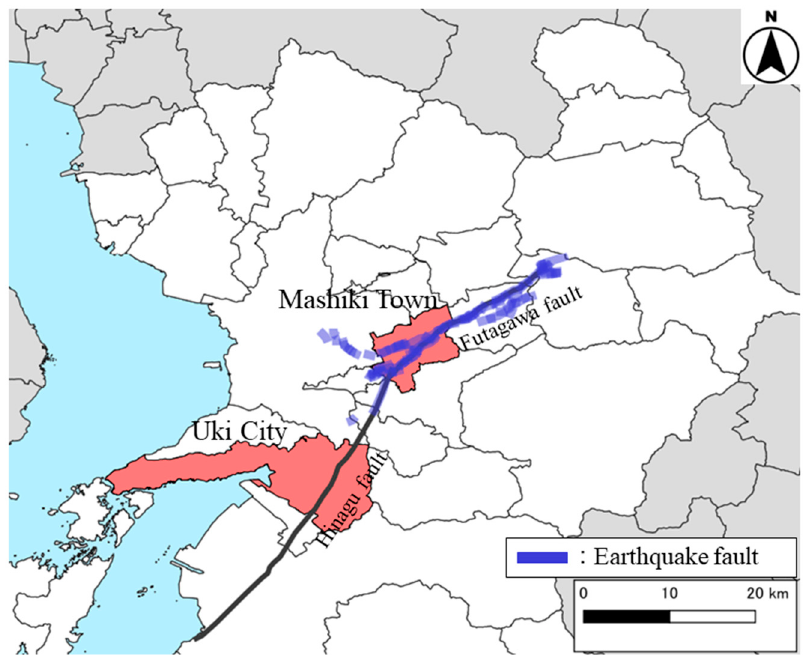
Figure 1. Study areas in the Kumamoto Prefecture, Japan. The black lines show the Futagawa and Hinagu faults, and the blue lines show the location of the earthquake fault. Municipal administrative boundaries and shoreline data were provided by GSI.